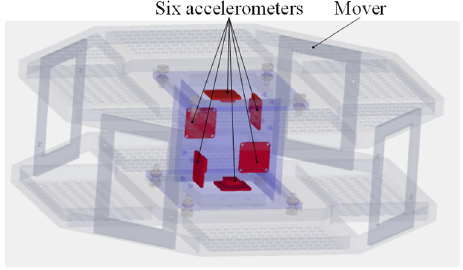
Figure 10. Detailed position of six